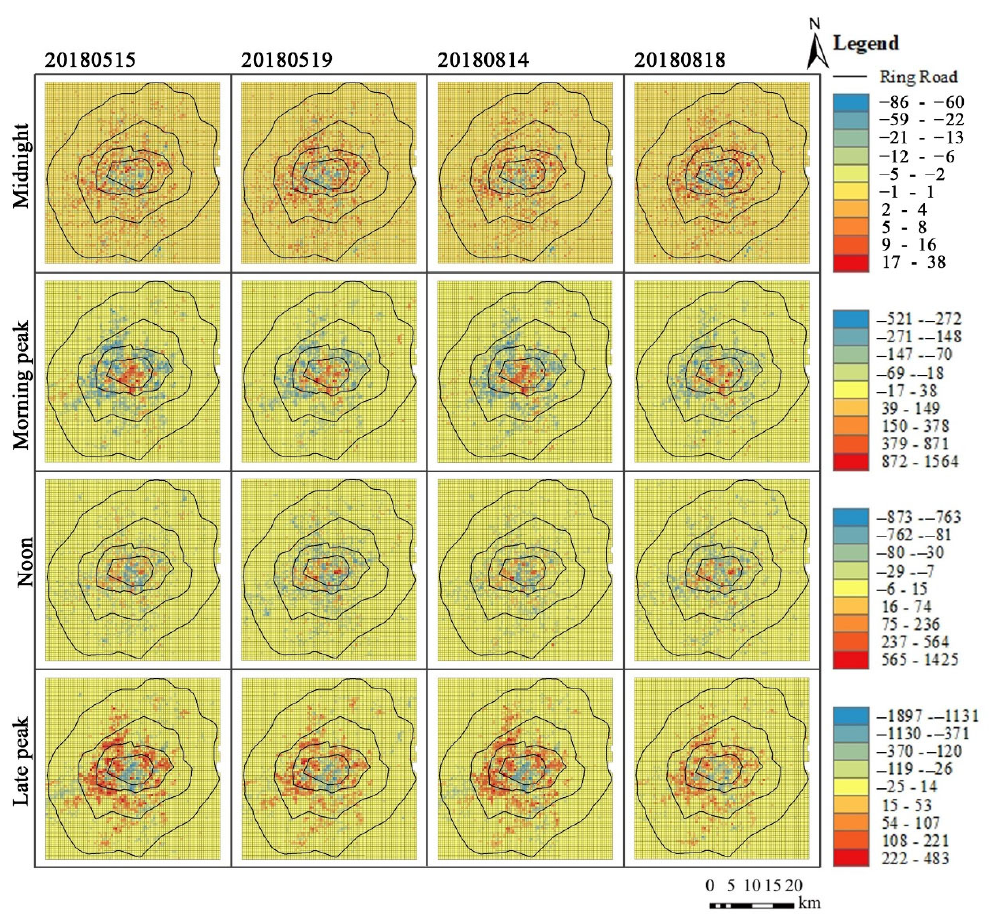
Figure 3. Distribution of population source ‐ sink at different dates and time periods.